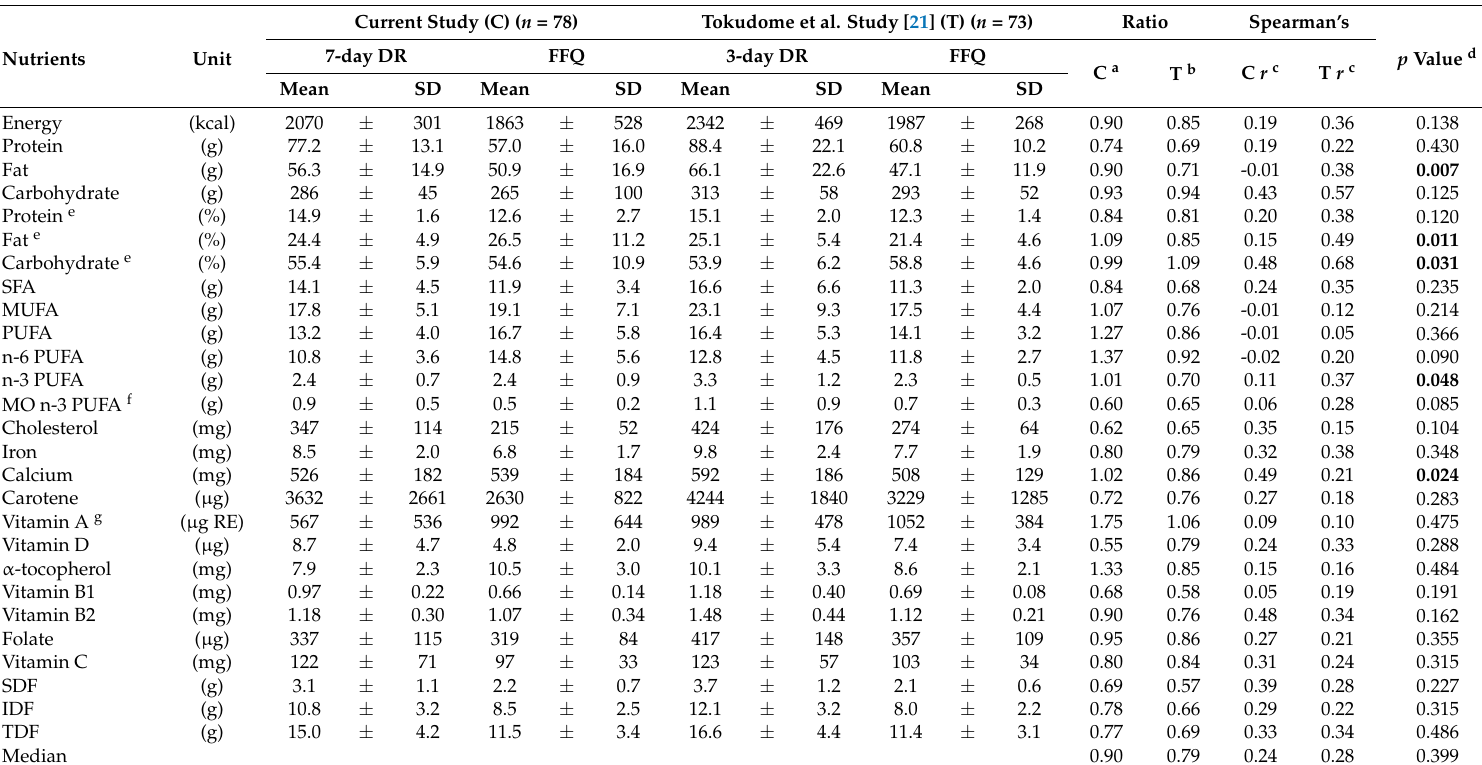
Table 3. Comparison of daily intakes of energy and nutrients measured using dietary records compared to that of a short food frequency questionnaire in